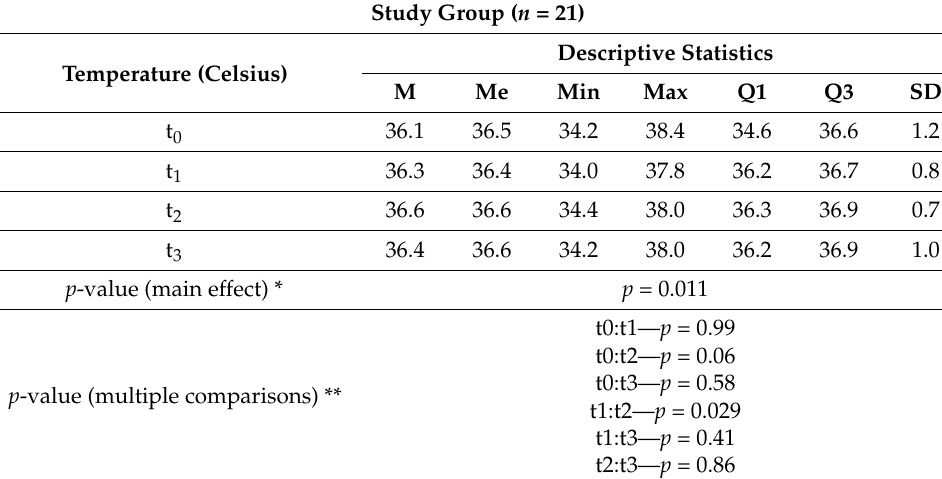
Study Group ( n = 21)